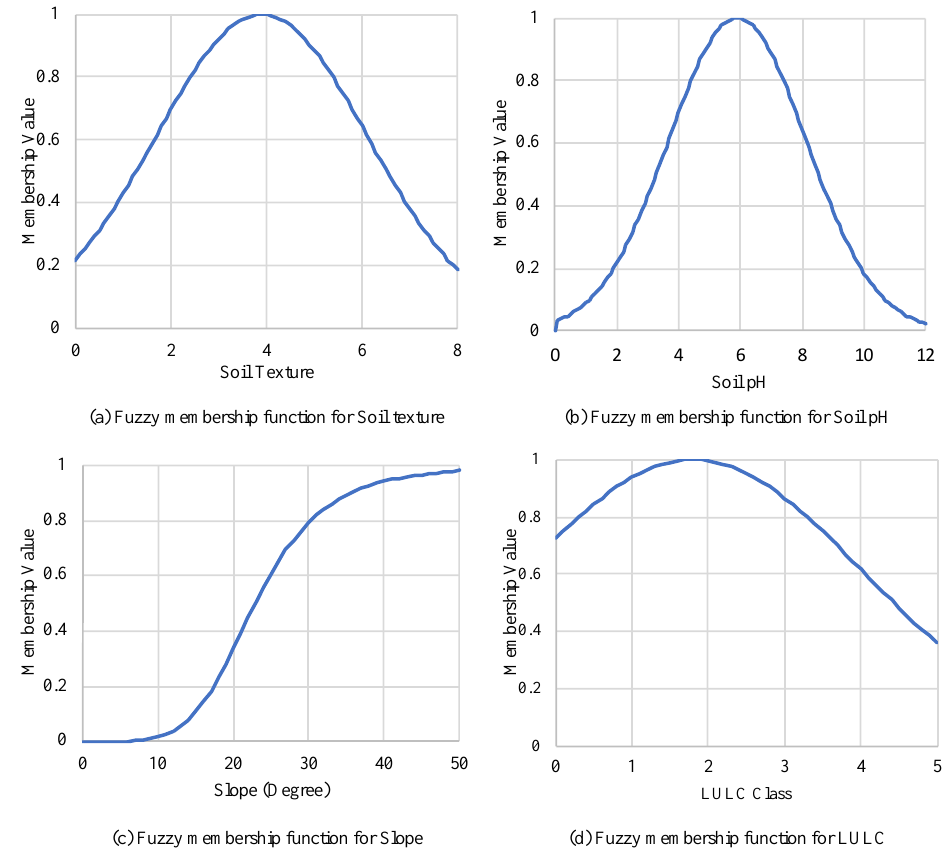
Figure 6. Fuzzy membership function for land suitability assessment to cultivate jute and sugarcane: ( a ) soil texture; ( b ) soil pH; ( c ) slope and ( d ) LULC. Elevation